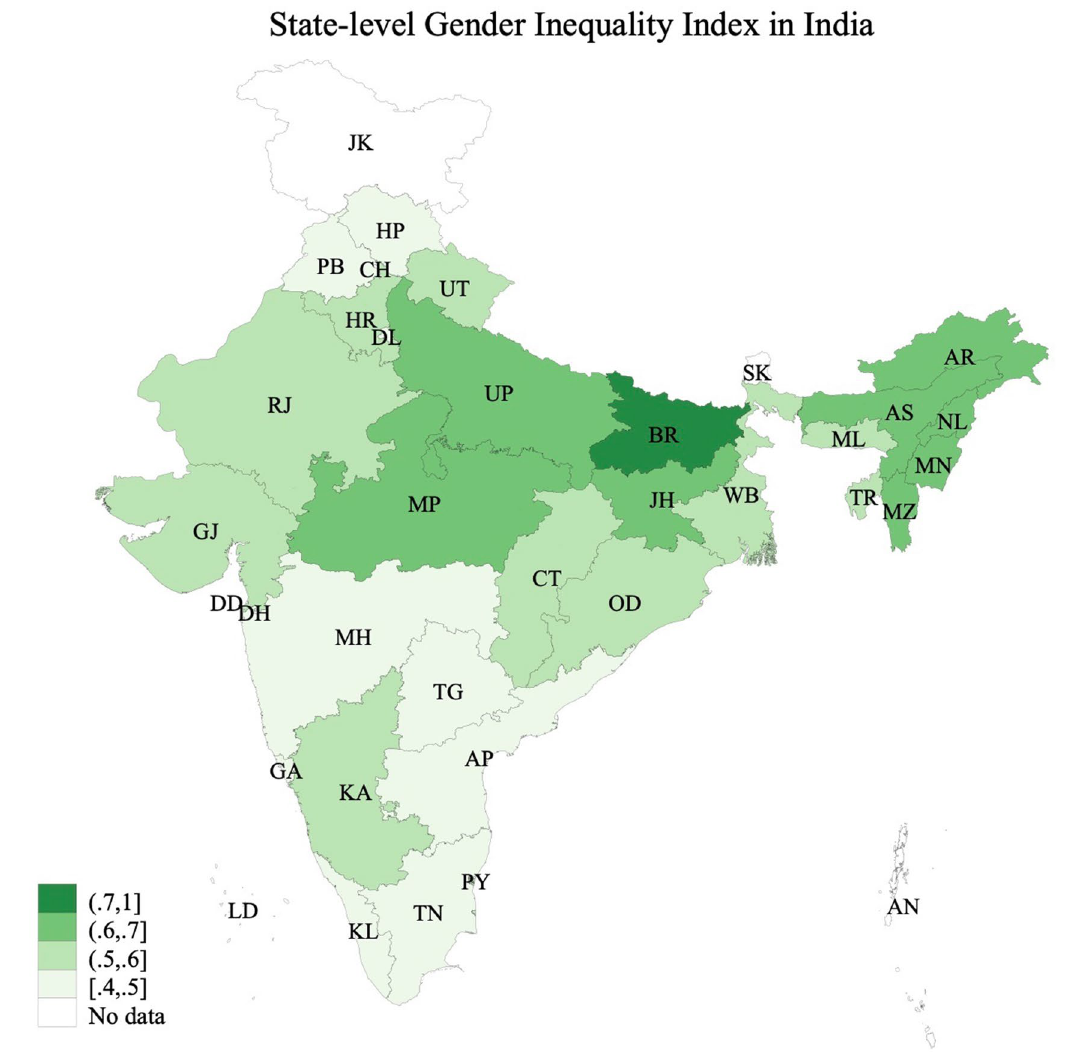
Figure 2. State-level Gender Inequality Index. Regions of India are defined as follows—North (Jammu and Kashmir, Himachal Pradesh, Punjab, Uttarakhand, Haryana, Delhi, Rajasthan, and Uttar Pradesh); East